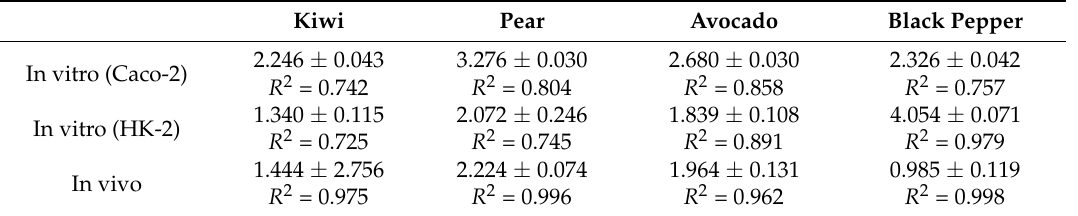
2.680 ± 0.030 R 2 = 0.858 1.839 ± 0.108 R 2 = 0.891 1.964 ± 0.131 R 2 = 0.962